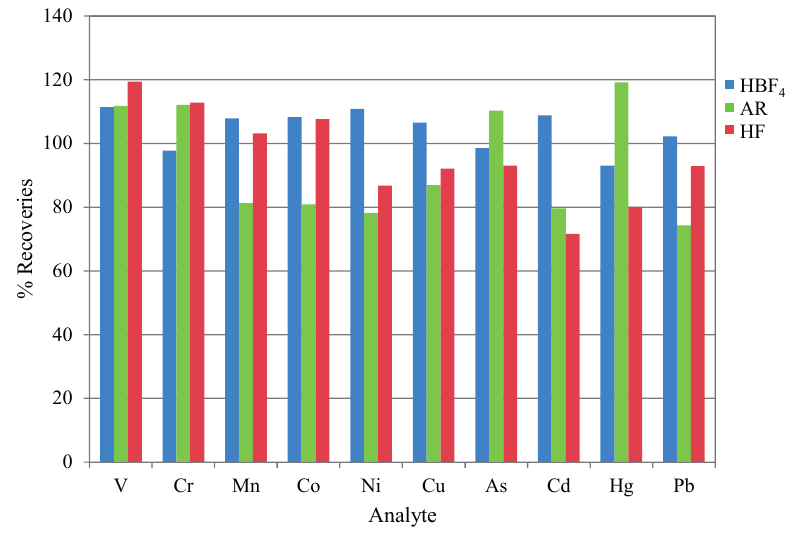
Figure 5. Comparison of the average recoveries obtained from the CRM BCR-038 using HBF 4 digestion, AR extraction and HF digestion (standard method). Indicative values only were given for V and Ni.